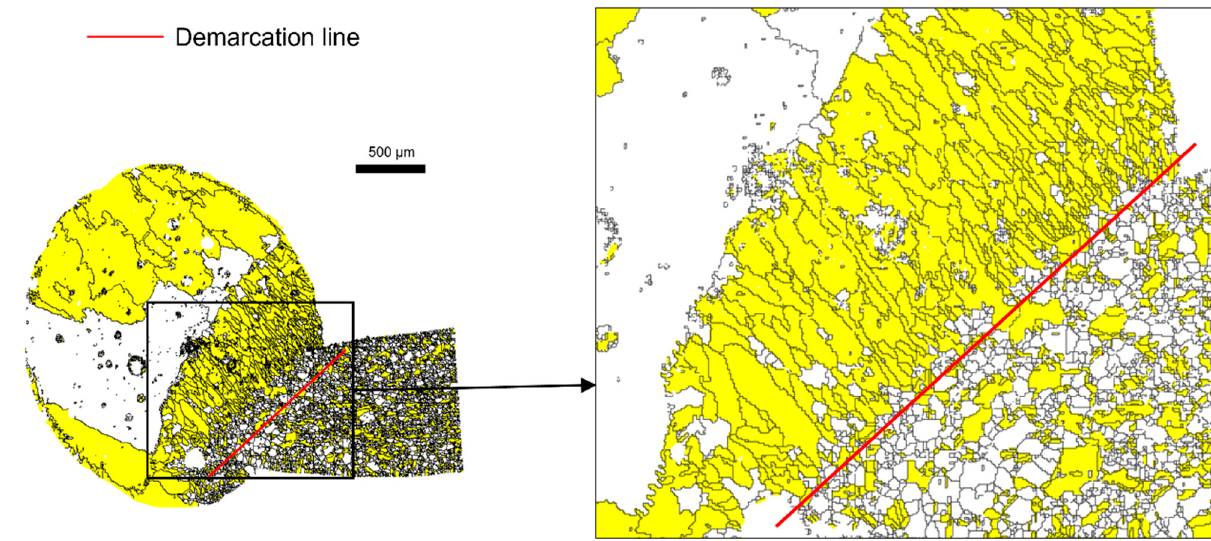
Figure 3. Set demarcation line of the molten mark: the region with grain aspect ratio (GAR) < 0.45 (yellow color) and demarcation line (red line).